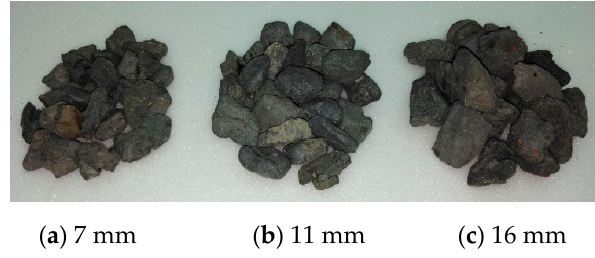
Figure 1. Particle shape of lightweight aggregate (LWA).